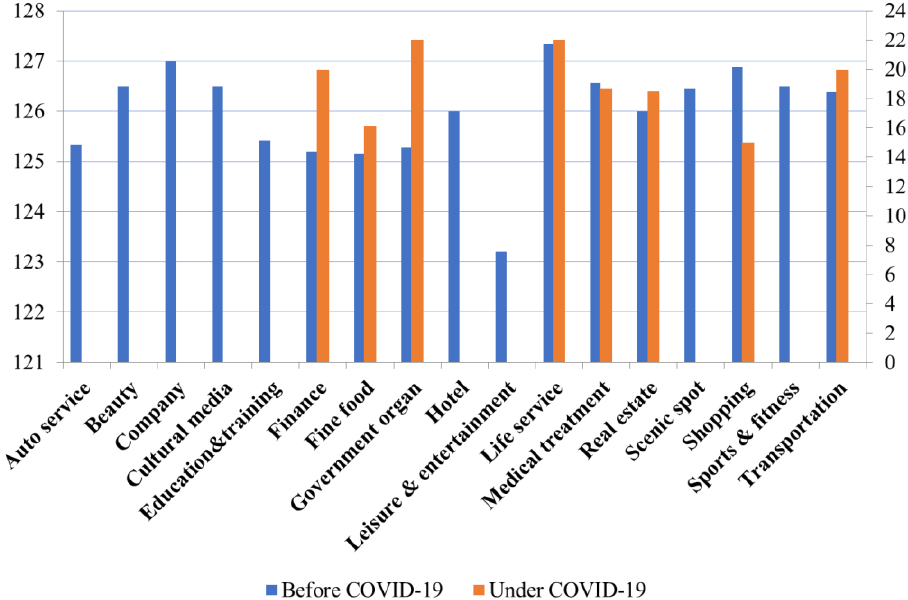
Figure 7. Mean degree of the primary categories before and under the lockdown of COVID-19.